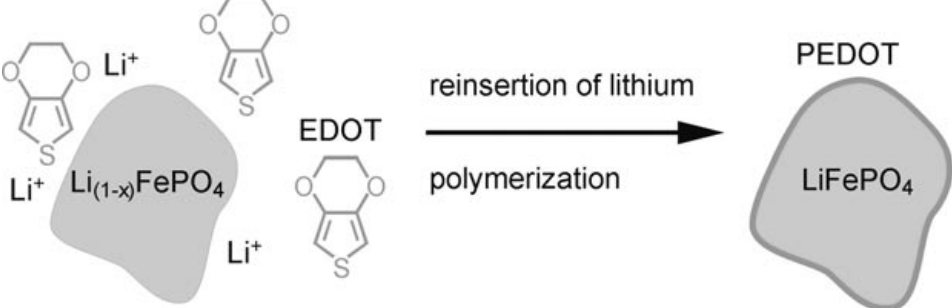
Figure 3. The polymerization reaction. The reinsertion of lithium into Li (1-x) FePO 4 leads to the oxidation of EDOT, which is deposited on the solid surface as the conducting polymer PEDOT [38]. Reprint with permission from [38]; Copyright 2011, John Wiley & Sons, Inc.